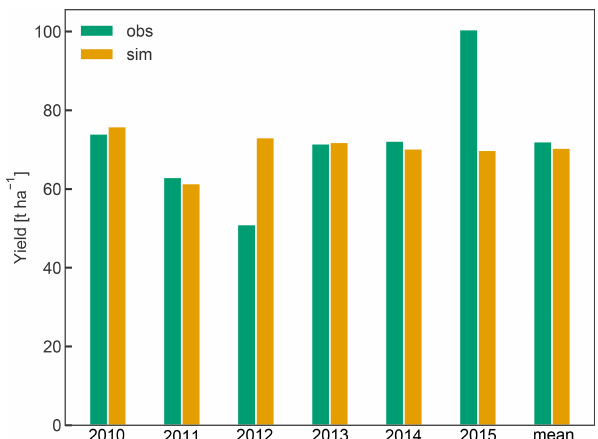
Figure 6. Annual yields from 2010 to 2015 and their mean in tons of fresh weight per hectare. For the conversion of simulated fruit biomass in gram carbon per square metre to tons per hectare, fruit C content was assumed to be 42% of total dry weight, harvest effi- ciency 95%, and fruit water content 83% according to Zanotelli et al.